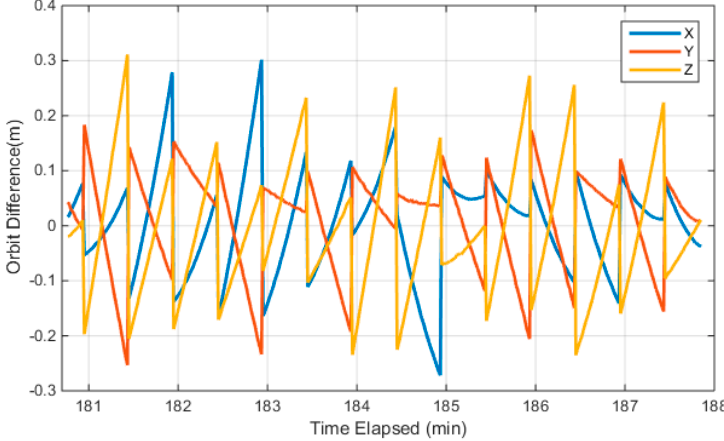
Figure 6. Internal precision of the Luojia-1A broadcast ephemeris.